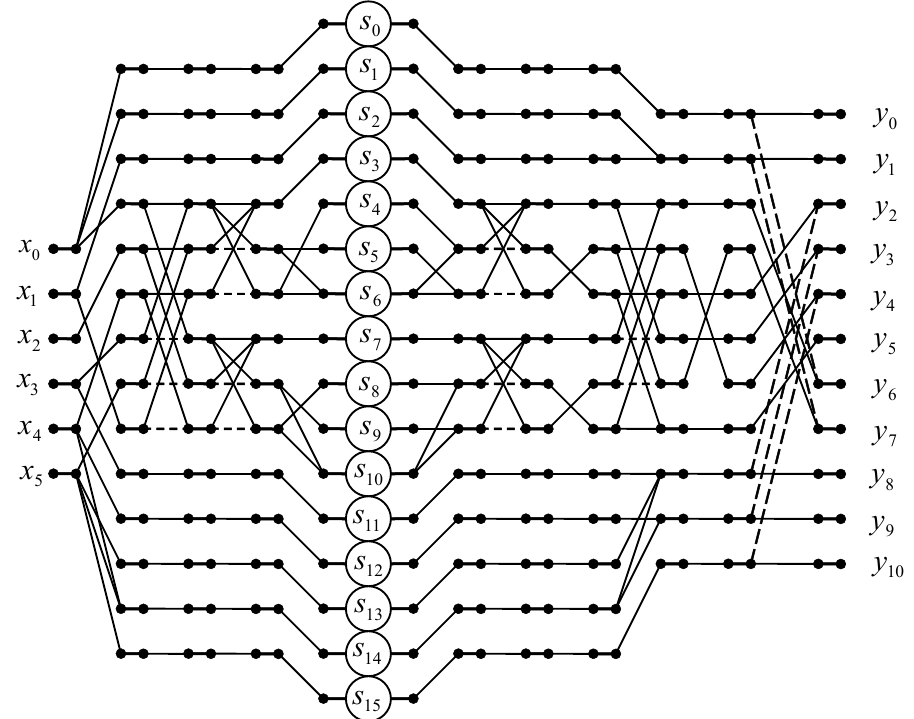
Figure 5. The signal flow graph of the proposed algorithm for computation of 6-point linear